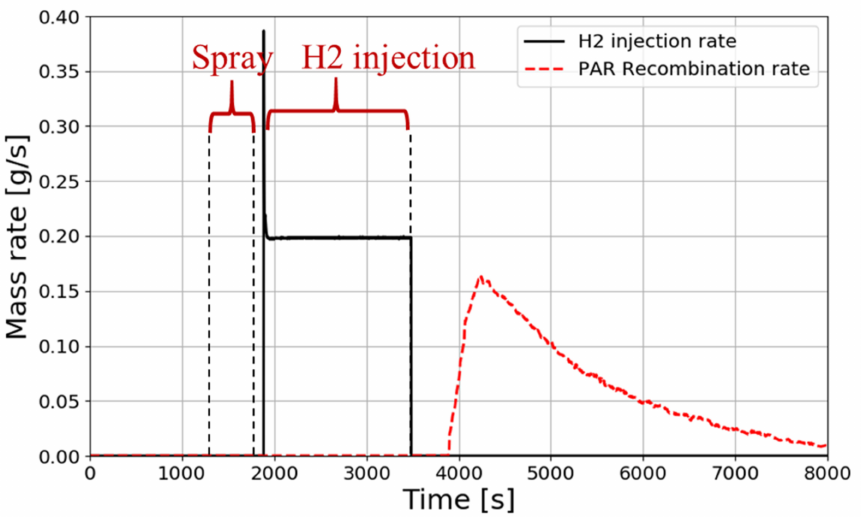
Figure 19. Changes in hydrogen injection and recombination over